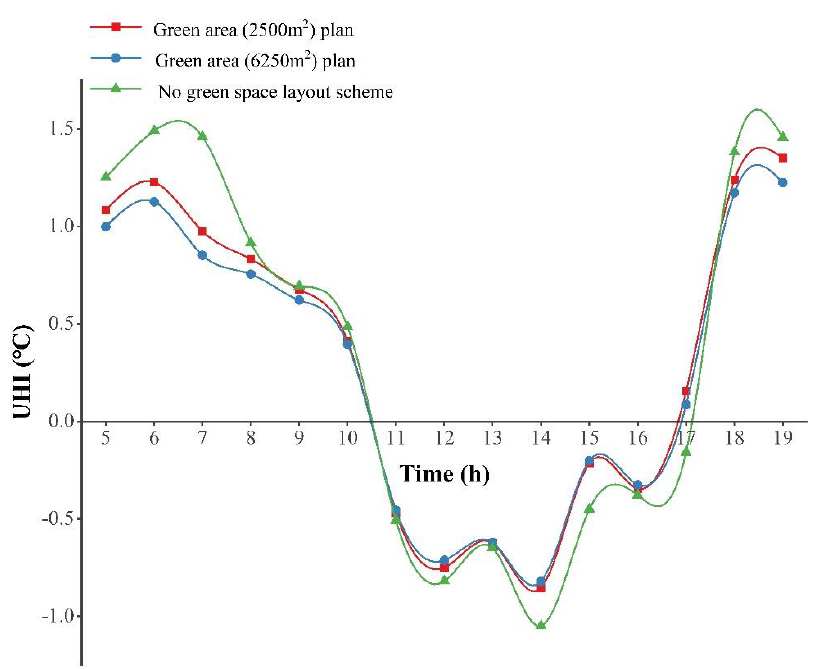
Figure 12. Mitigation effects curve of increasing green space layout area on heat island.